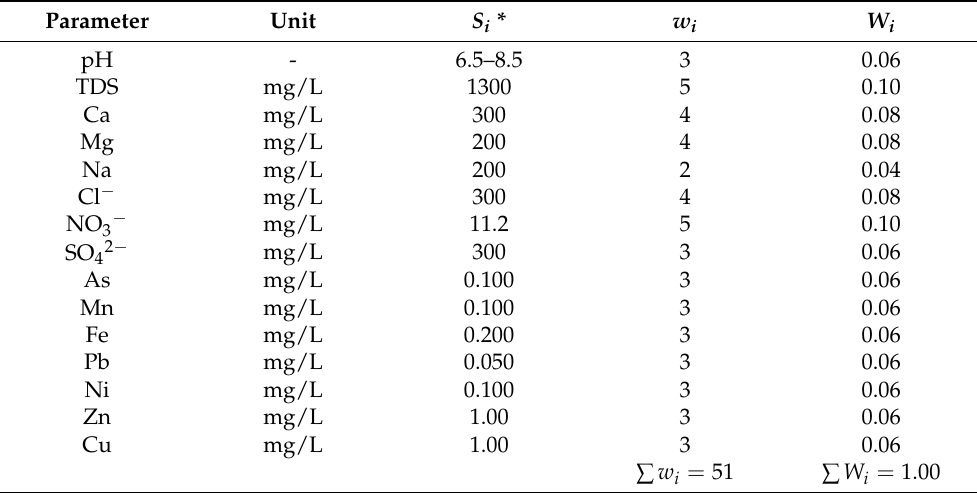
Table 2. List of the parameter values ( S i ), weights ( w i ) and relative weights ( W i ) used for the calculation of the